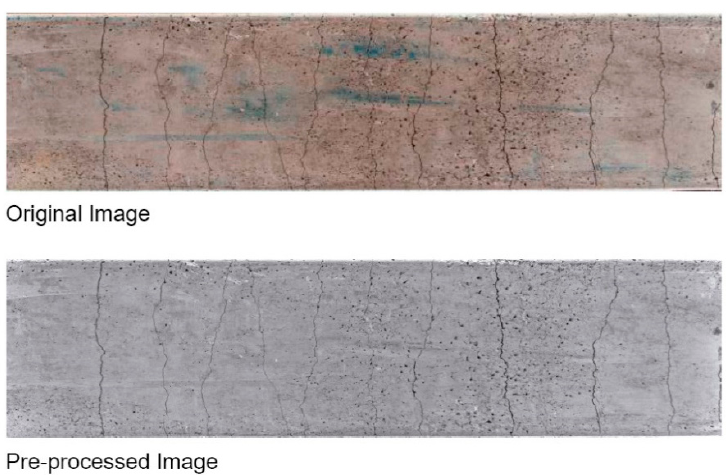
Figure 16. Original and pre-processed image after initial enhancements.